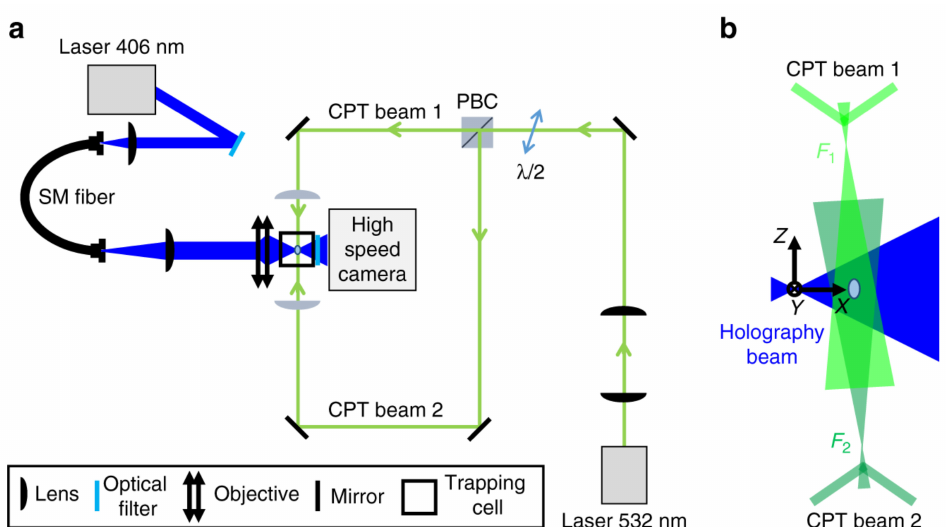
Figure 12. Optical trapping digital holography experimental setup. ( a ) Green lines: counter- propagating optical tweezer (CPT) for particle trapping. Blue lines: laser beam for holographic imaging. ( b ) Detail of the relative arrangement of the holography and CPT beams. The origin of the coordinate system corresponds to the focus of the holography laser. The X-axis corresponds to the propagation direction of the holography laser. The optical axis of the CPT is slightly tilted with respect to the Z-axis (reprinted from [200], with permission under Creative Commons Attribution license, Copyright (2018)